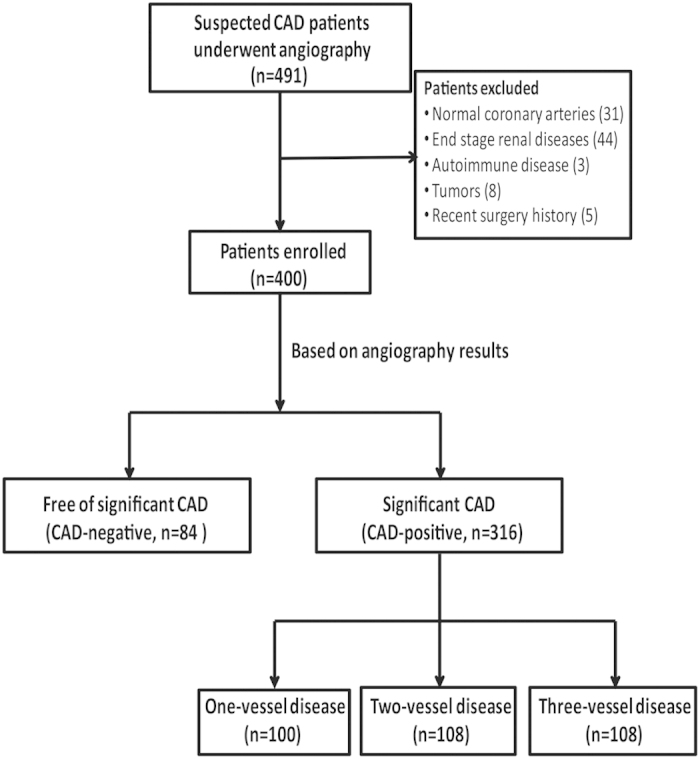
Flow chart of patient enrollment.CAD, coronary artery disease.